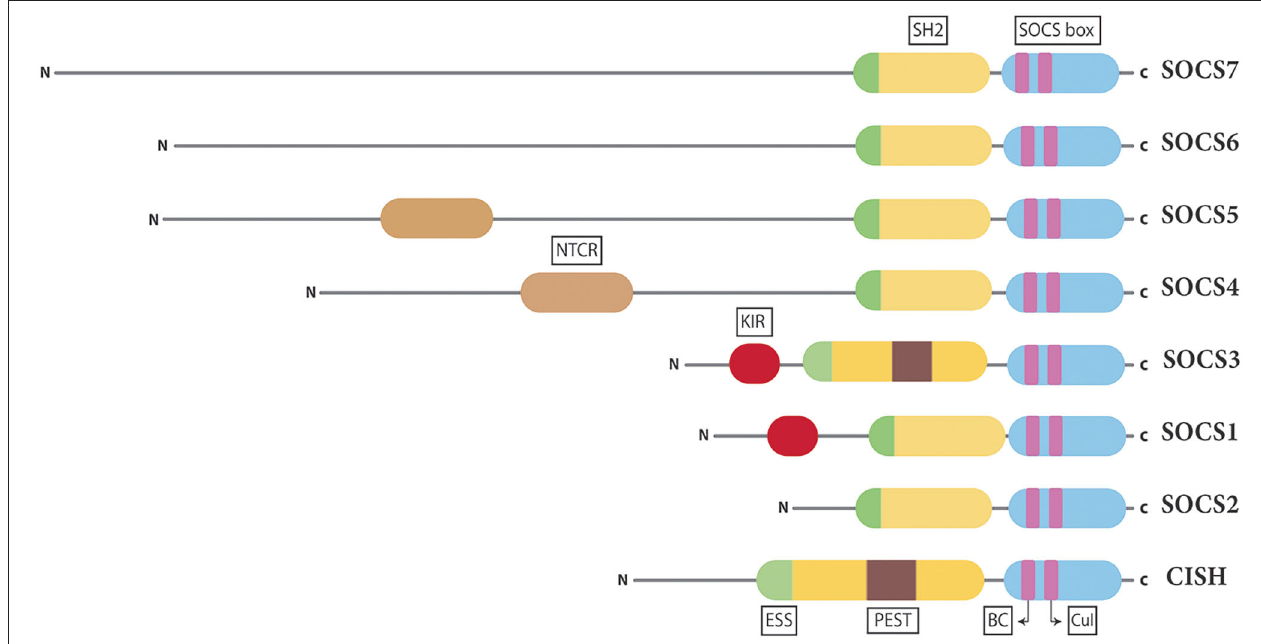
FIGURE 2 | Structure of the SOCS proteins. Schematic representation of the eight mammalian SOCS proteins presented in pairs based on conserved structure and function. Shown are the universal central SH2 domain (yellow), including a unique extra α -helical structure termed the extended SH2 domain (ESS) (green) found in all SOCS proteins and a PEST motif (purple) found in SOCS3 and CISH as well as the C-terminal SOCS box domain (blue), containing Elongin BC (BC) and Cullin (Cul) boxes (pink). In addition, there is a variable N-terminal domain, containing a specialized kinase inhibitory region (KIR) in SOCS1 and SOCS3 (red) and an N-terminal conserved region (NTCR) in SOCS4 and SOCS5